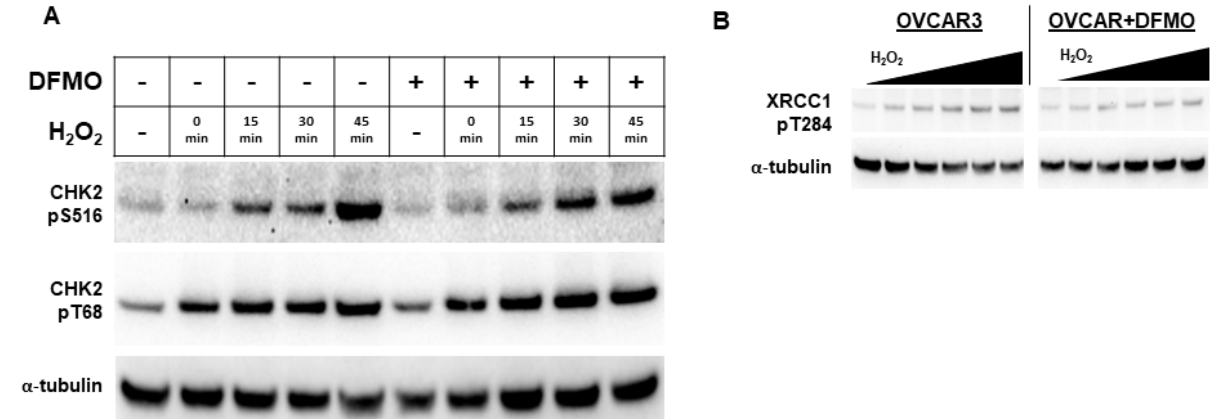
Figure 4. DFMO suppresses CHK2 kinase function and XRCC1 in OVCAR3 cells. ( A ) OVCAR3 cells were pretreated with 1 mM DFMO for 24 h and then treated with a 20 min pulse with 4 mM H 2 O 2 , followed by an incubation in drug-free or DFMO-containing media for up to 45 min. Cell lysates were probed for CHK2 phospho-serine 516, CHK2 phospho-threonine 68, and α -tubulin for a loading control in a Western blot assay. ( B ) OVCAR3 cells pretreated with 2 mM DFMO for 24 h prior to receiving 20 min treatments with varying concentrations of H 2 O 2 show reduced XRCC1 T284 phosphorylation compared to controls. H 2 O 2 was washed out and cells were incubated for 45 min before harvest with RIPA lysis buffer. Lysates were immunoblotted for XRCC1 pT284, and were normalized to the loading control, α -tubulin.